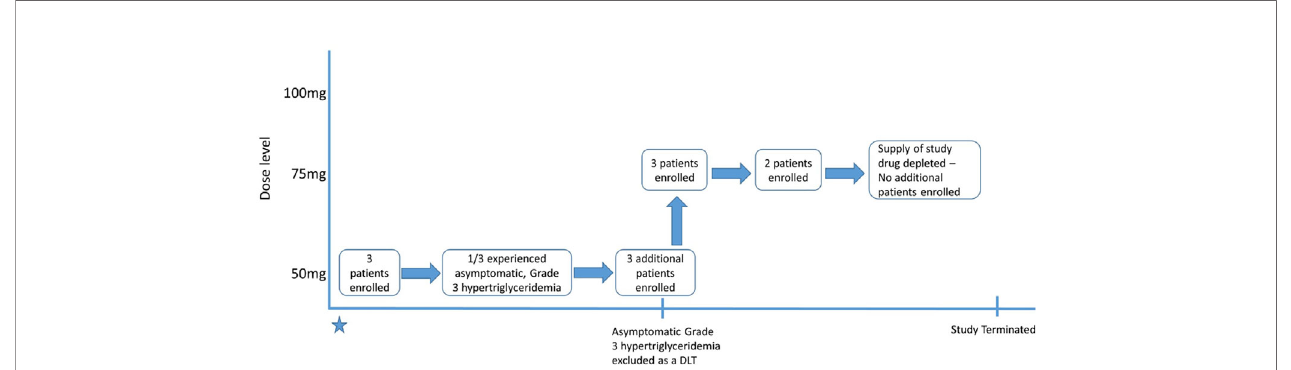
FIGURE 2 | Flow chart diagramming patient enrollment. DLT, Dose-limiting